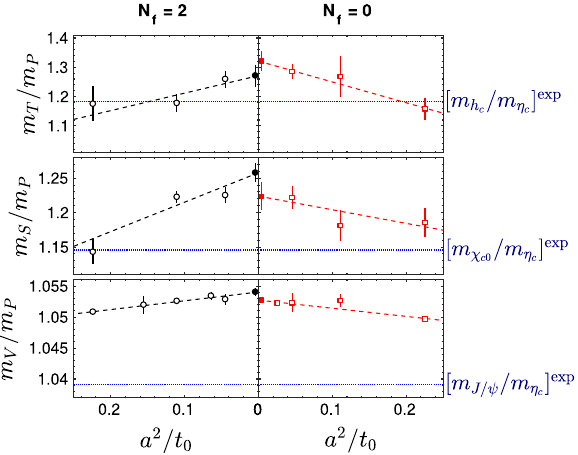
Fig. 5 Continuum limits of the meson mass ratios m V / m P , m S / m P and m T / m P in both the N f = 2 (left) and N f = 0 (right) theories. The dotted lines indicate the value of the corresponding ratio in nature